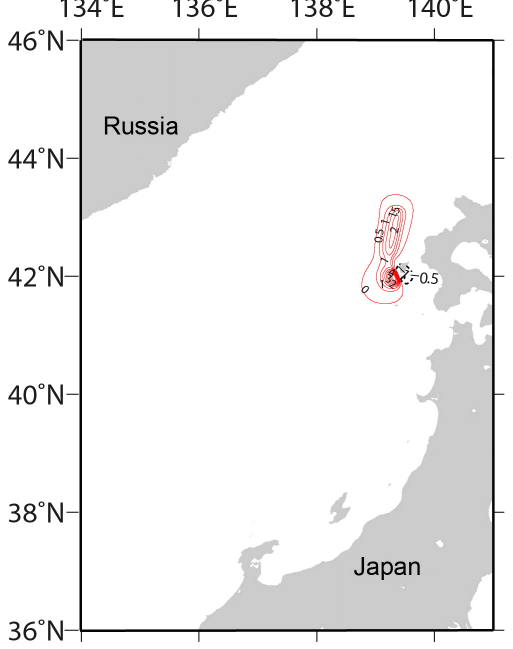
Fig. 3. The location and initial water elevations of the 1993 event. Solid and dashed lines indicate the positive and negative values, respectively. The contour interval is 0.5m.